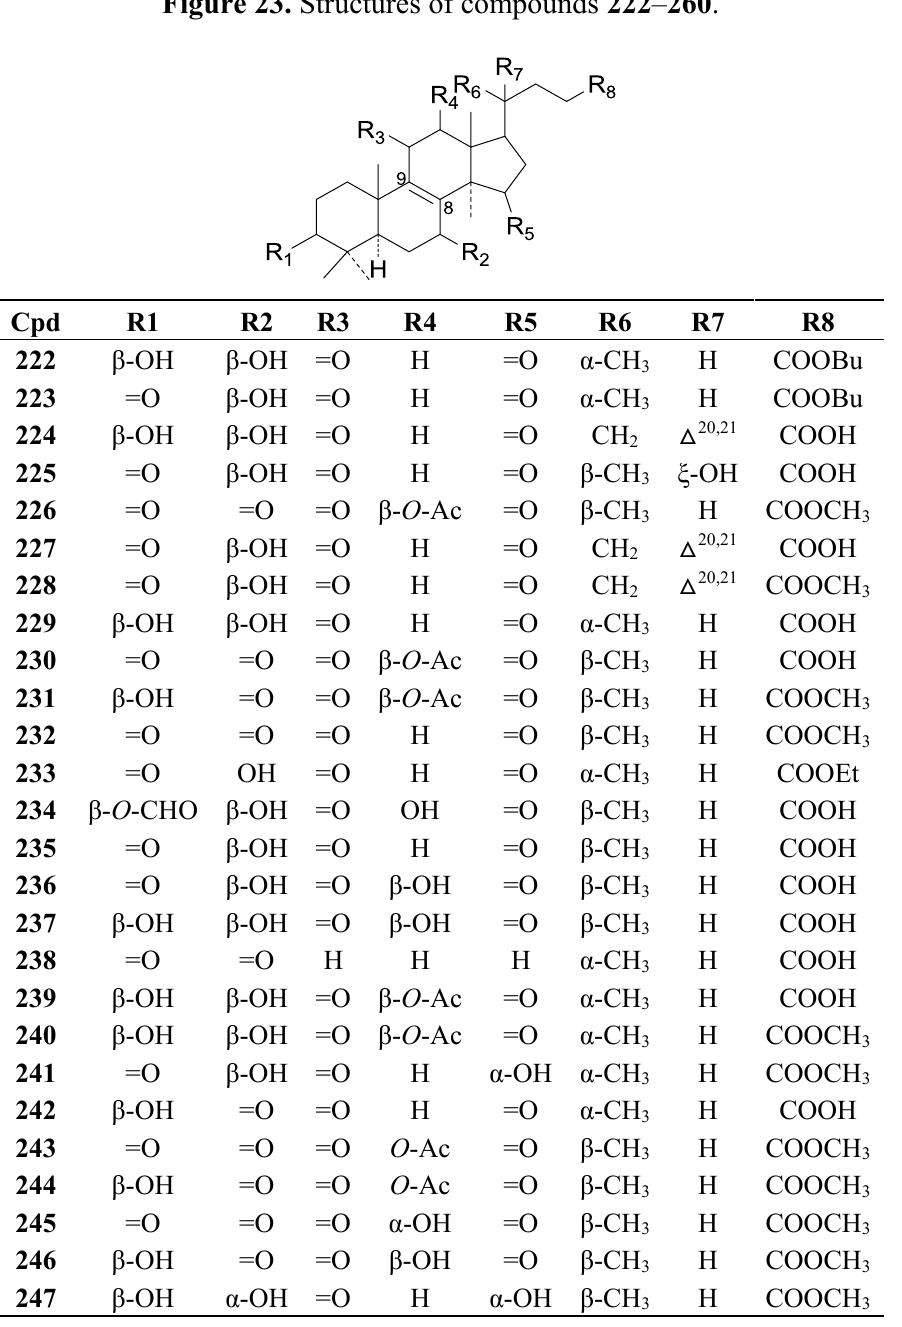
Figure 23. Structures of compounds 222 – 260